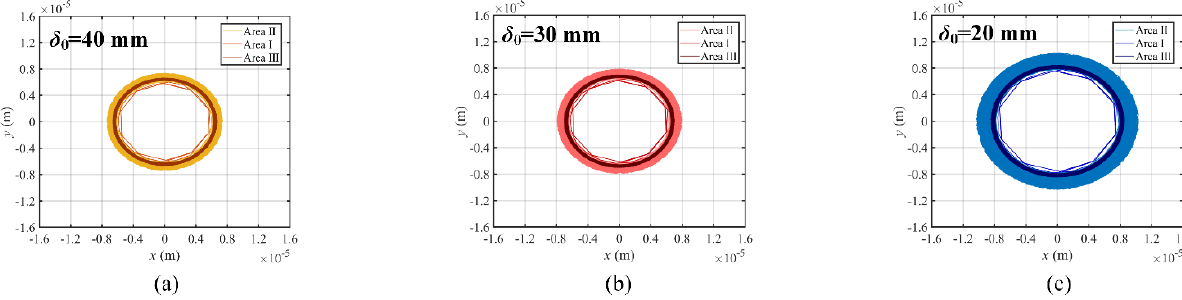
Figure 21. The axis trajectory of the generator rotor under different average air gaps between the stator and rotor. ( a ) δ 0 = 40 mm; ( b ) δ 0 = 30 mm; ( c ) δ 0 = 20 mm.